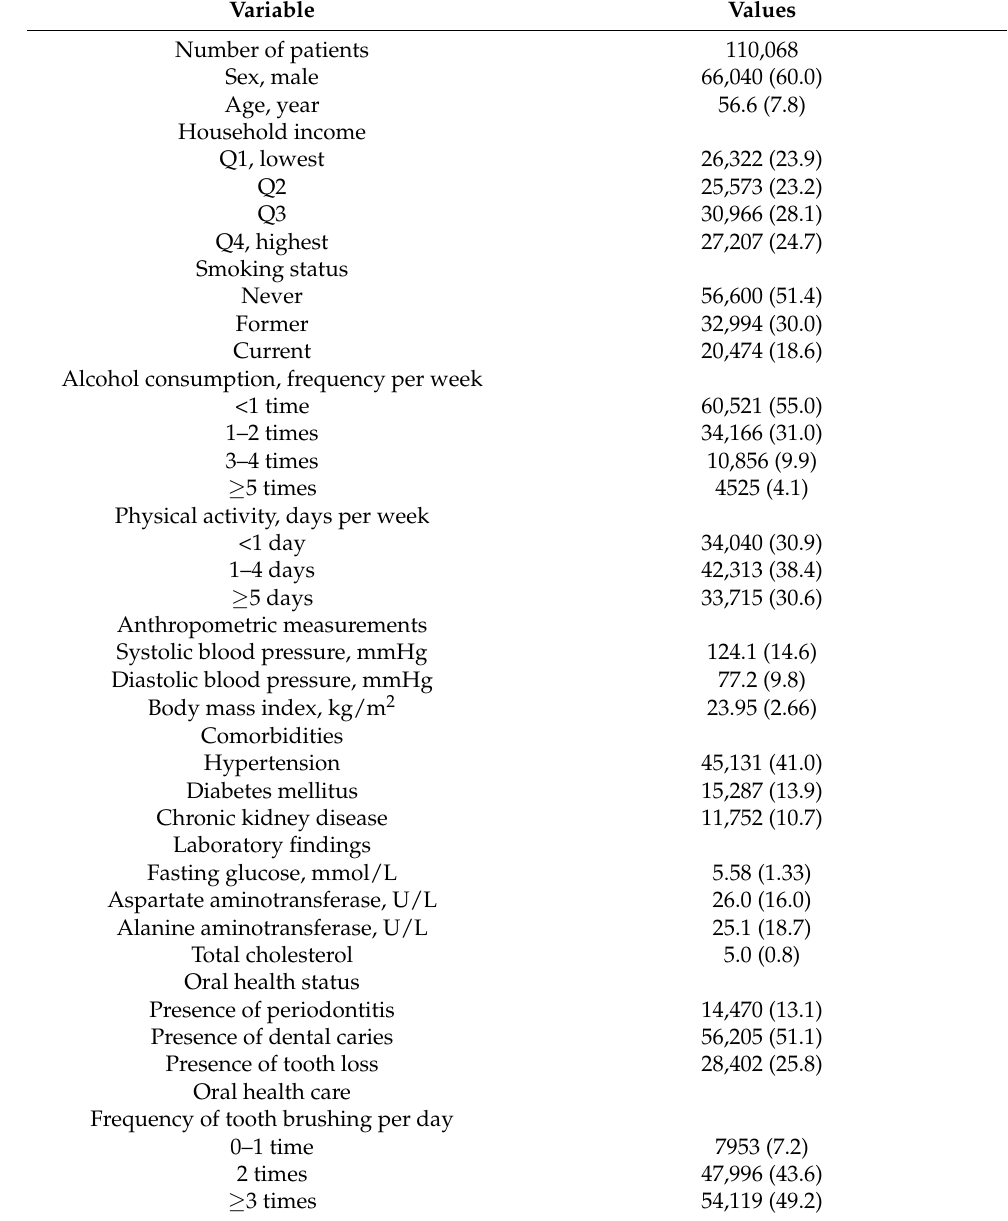
Table 2. Characteristics of patients at baseline